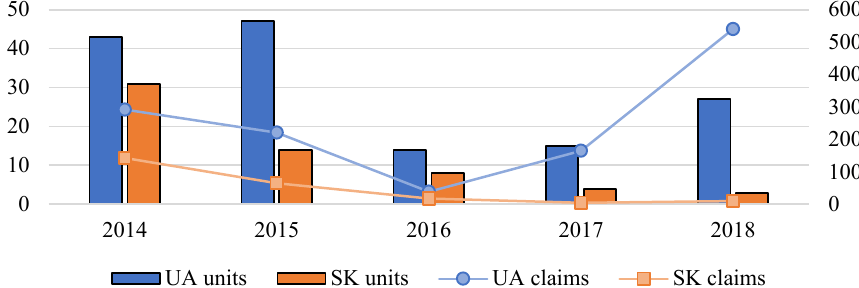
Figure 1. Number of textual units ( left ) and claims ( right ) analysed for both examined countries. Source: Authors’ calculations. Note: Ukraine (UA); Slovakia (SK).